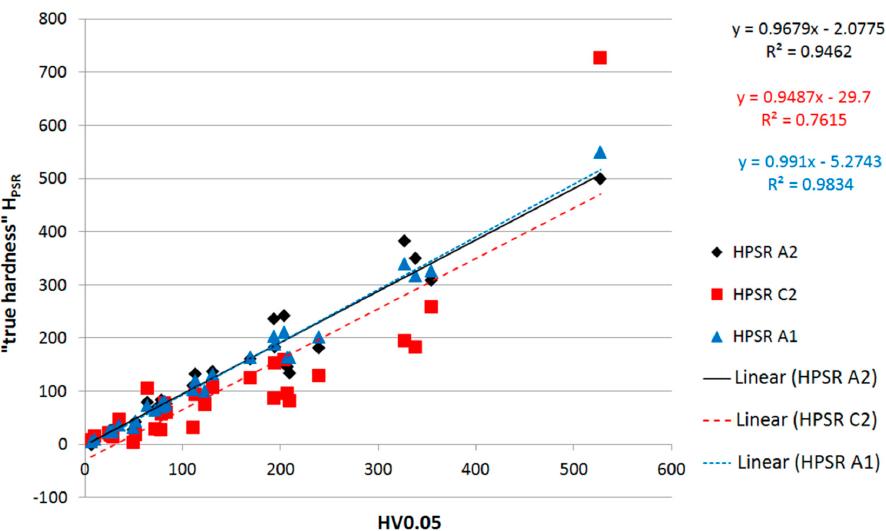
Figure 3. The relationship between Meyer’s index n and W, the minimum test load W (N) necessary to initiate plastic deformation.